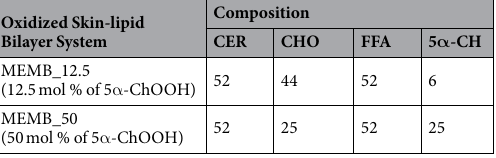
taken from Neto et al . 23 The simple point charge (SPC) model was used for the water molecules 34 . ROS parame-